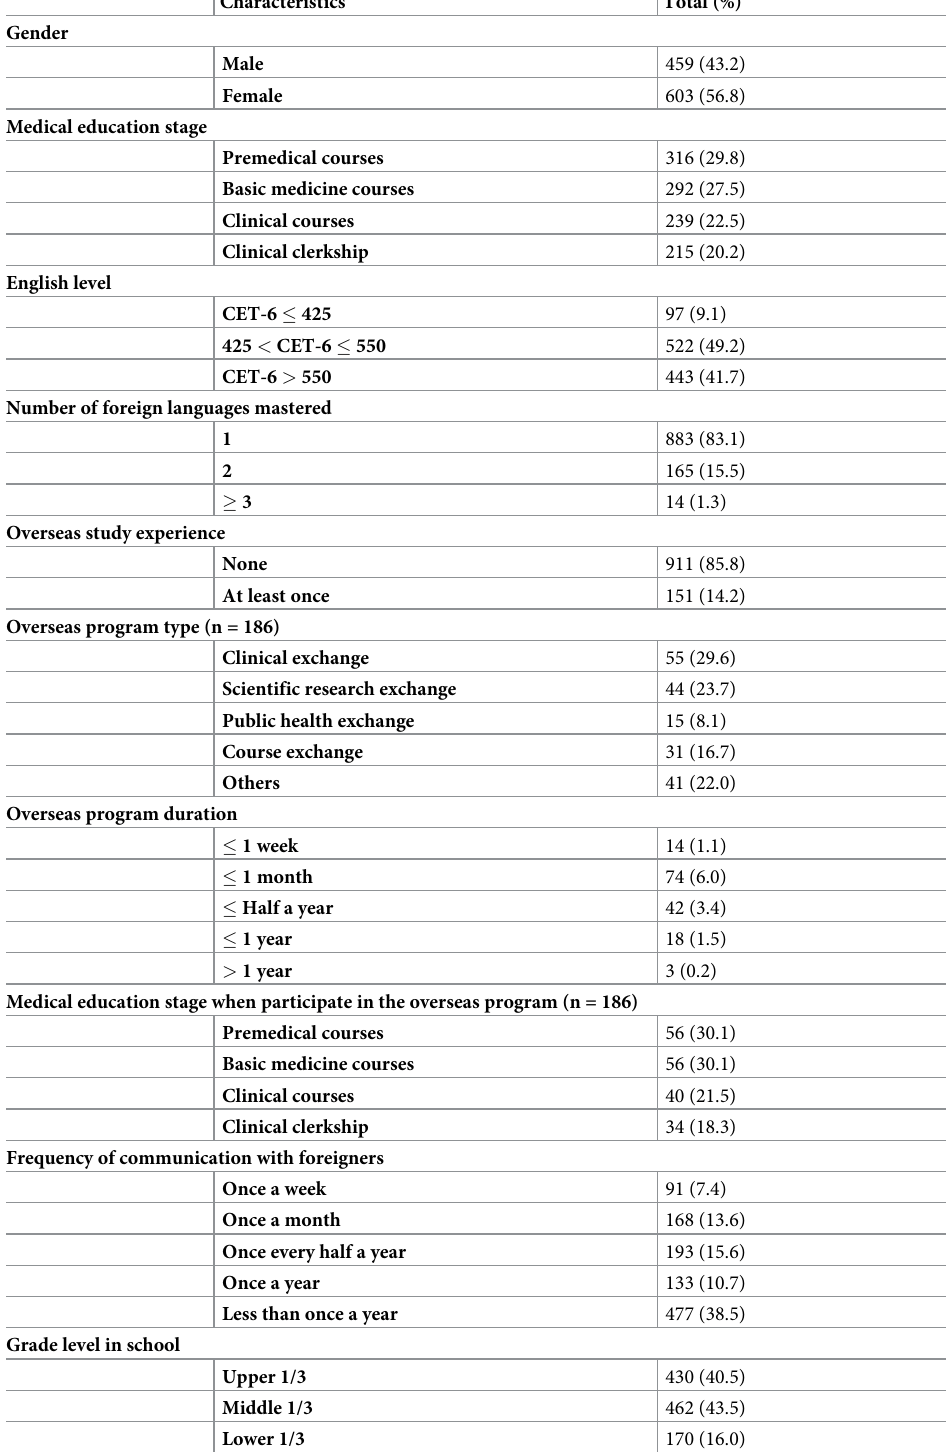
Table 1. Characteristics of the 1062 surveyed medical